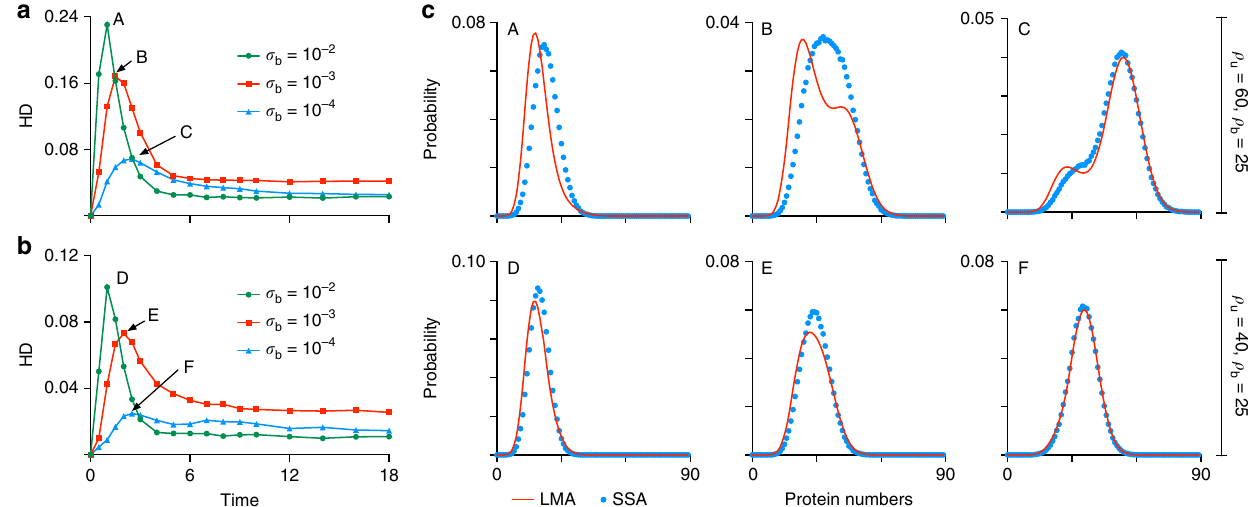
Fig. 3 Dependence of the LMA approximation error on parameters in non-oscillatory feedback loops. a , b Show the variation of the Hellinger distance (HD) between LMA and SSA distributions for protein numbers in the cooperative feedback loop as a function of time, σ b and ρ u − ρ b . The results show that the HD reaches its maximum at intermediate times and that this value is an increasing function of σ b (the rate parameter controlling the degree of nonlinearity in the nonlinear GRN) and of the difference in gene expression between the two promoter states ( ρ u − ρ b ). The other parameters are: cp = 2, σ u = 0.25. c Compares the LMA predictions and SSA distributions for six time points (at which the HD maximizes) as indicated in a ,